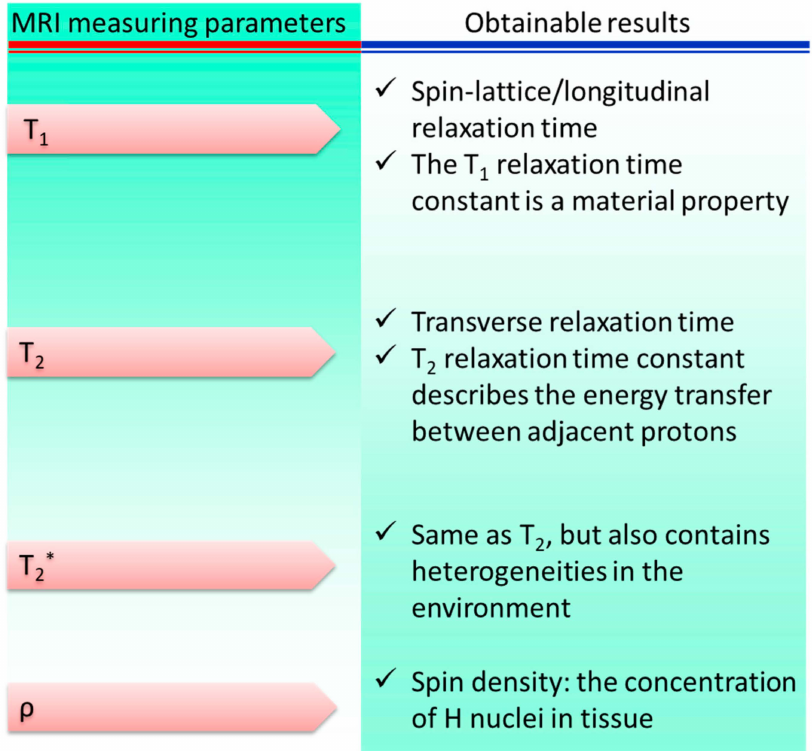
Figure 4. Parameters of magnetic resonance imaging: sources of signal variation. * represents a separate